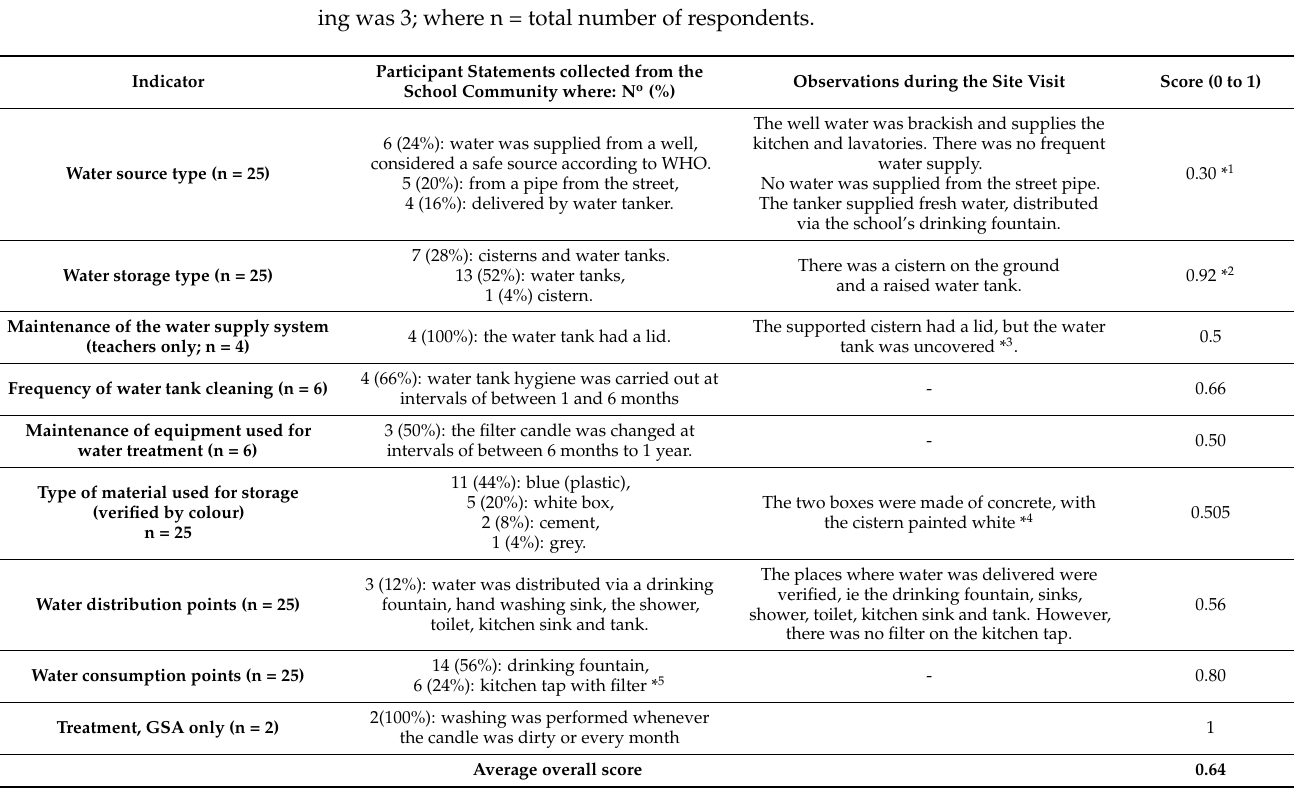
Table 6. Results of the survey carried out for the Technological Dimension and its indicators. Weight- ing was 3; where n = total number of